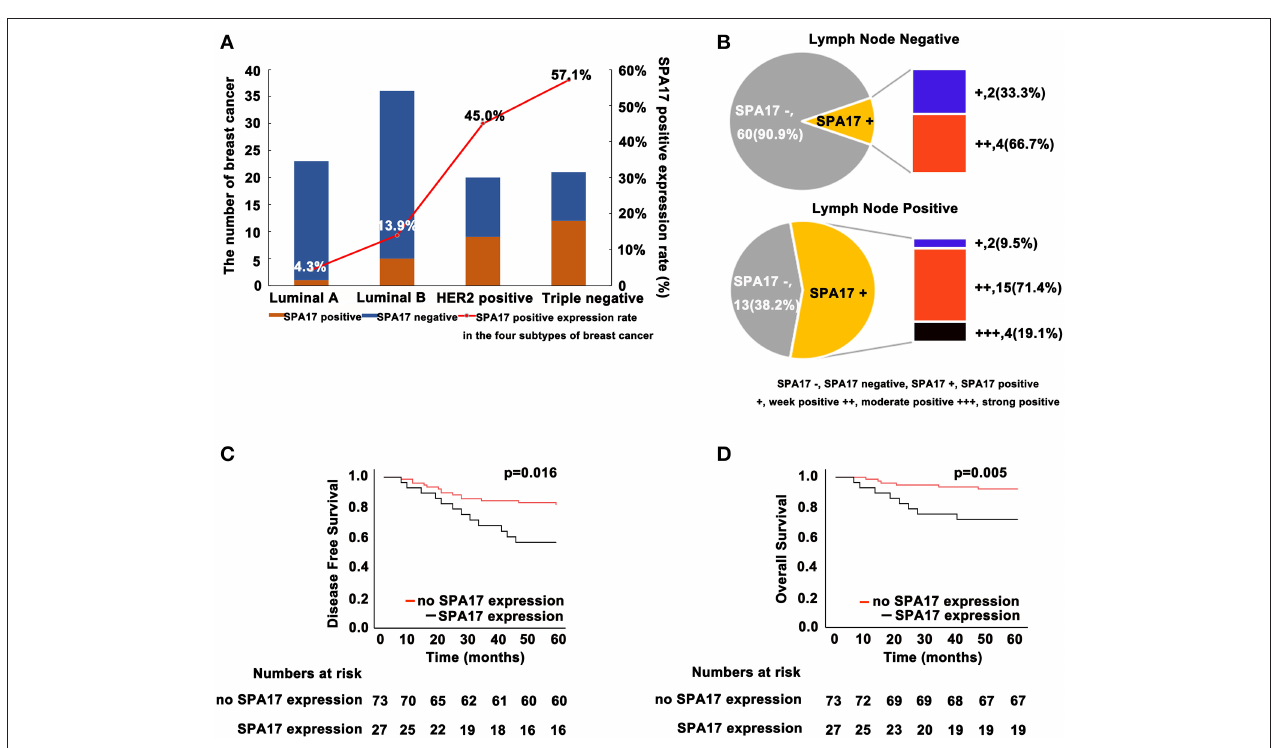
FIGURE 3 | (A) SPA17 protein expression status in four molecular subtypes of breast cancer. SPA17 protein expression was positive in the majority of non-luminal breast cancer tissues. (B) SPA17 protein expression in lymph node negative and lymph node positive breast cancer patients. (C) SPA17 positive expression is associated with lower disease-free survival and (D) overall survival among breast cancer